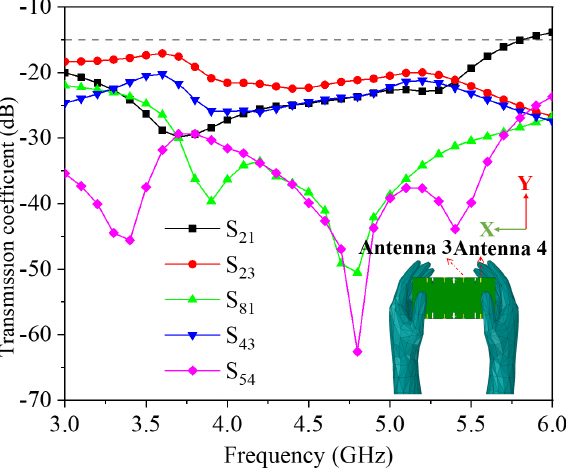
Figure 7. The simulated transmission coefficients of the designed antenna in DHM.